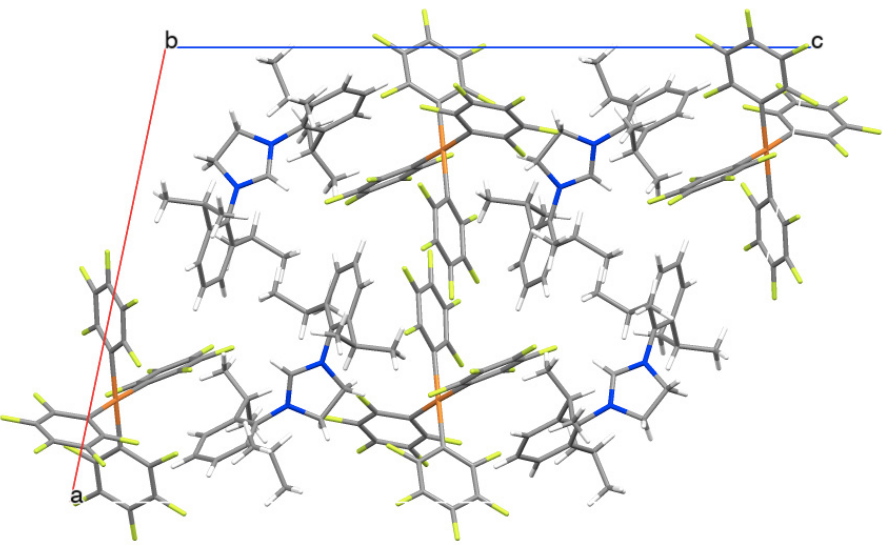
Figure 8. View along b axis of the crystal packing of 4 . The axis are represented as a, b,